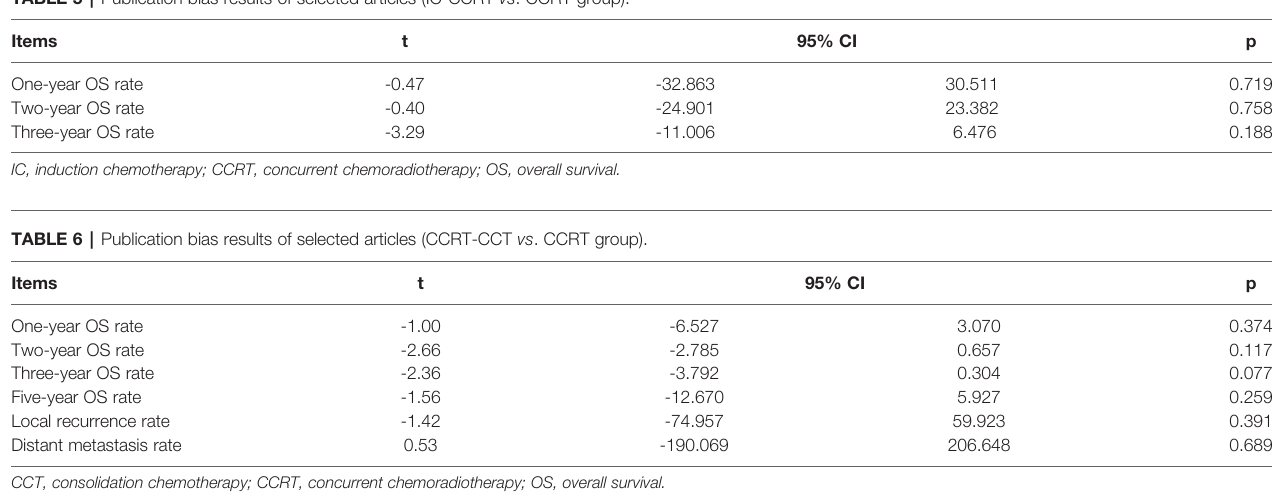
TABLE 5 | Publication bias results of selected articles (IC-CCRT vs . CCRT group).